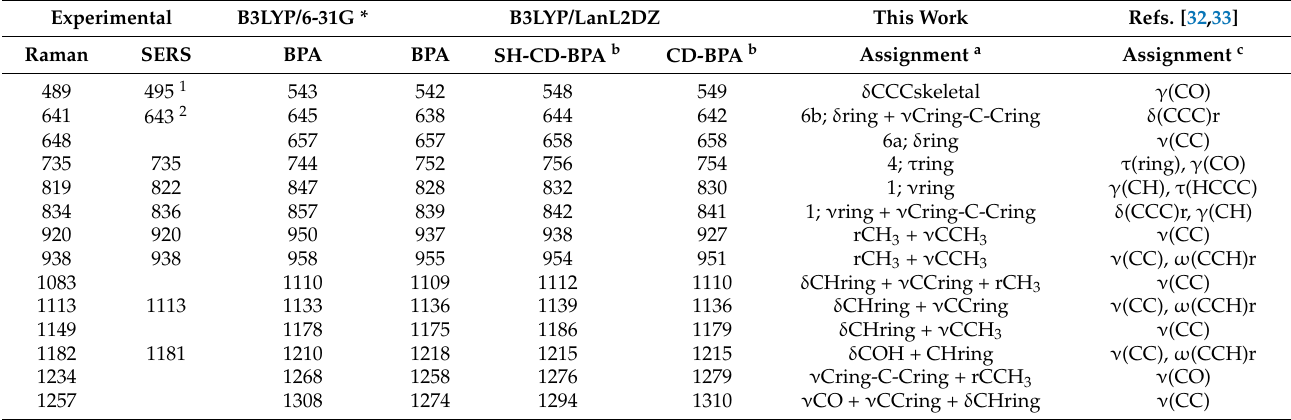
1 Overlapped with the band at 480 cm − 1 of CD-SH; 2 overlapped with the band at 643 cm − 1 of CD-SH; a ν : stretching; δ : in-plane deformation; r: rocking; τ : torsional deformation. Wilson’s nomenclature for the benzene-like normal modes, 6a, 6b, 1, and 4 [46]. Vibrational modes visualized by using MOLDEN program [47]; b vibrational wavenumbers of the most stable CD-BPA complex (see Figure 3e); c ω , wagging; r,